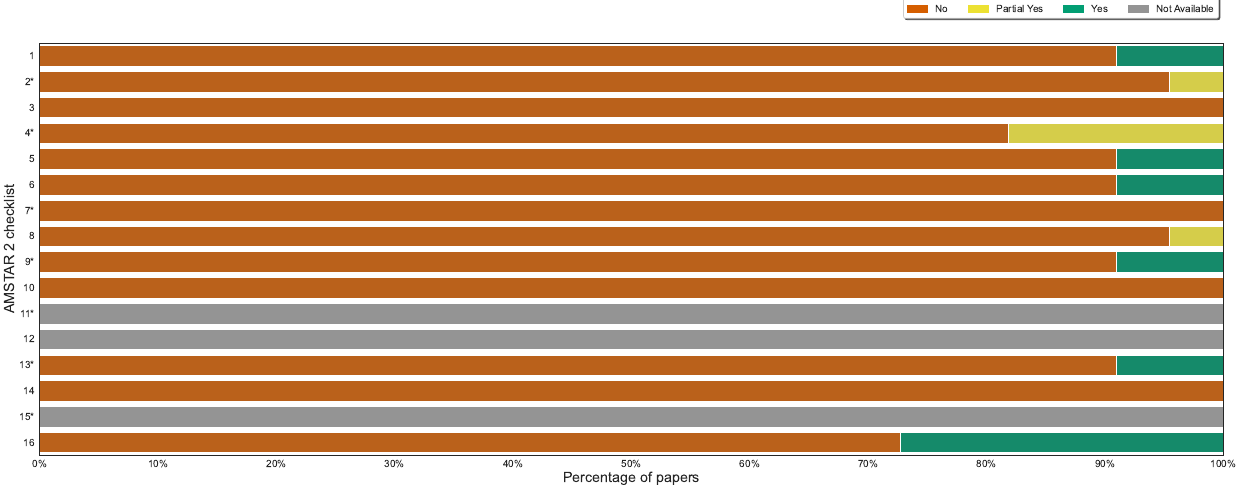
Figure 2. Quality graph: our judgements on each AMSTAR 2 item presented as the percentage of all the included studies; * denotes critical